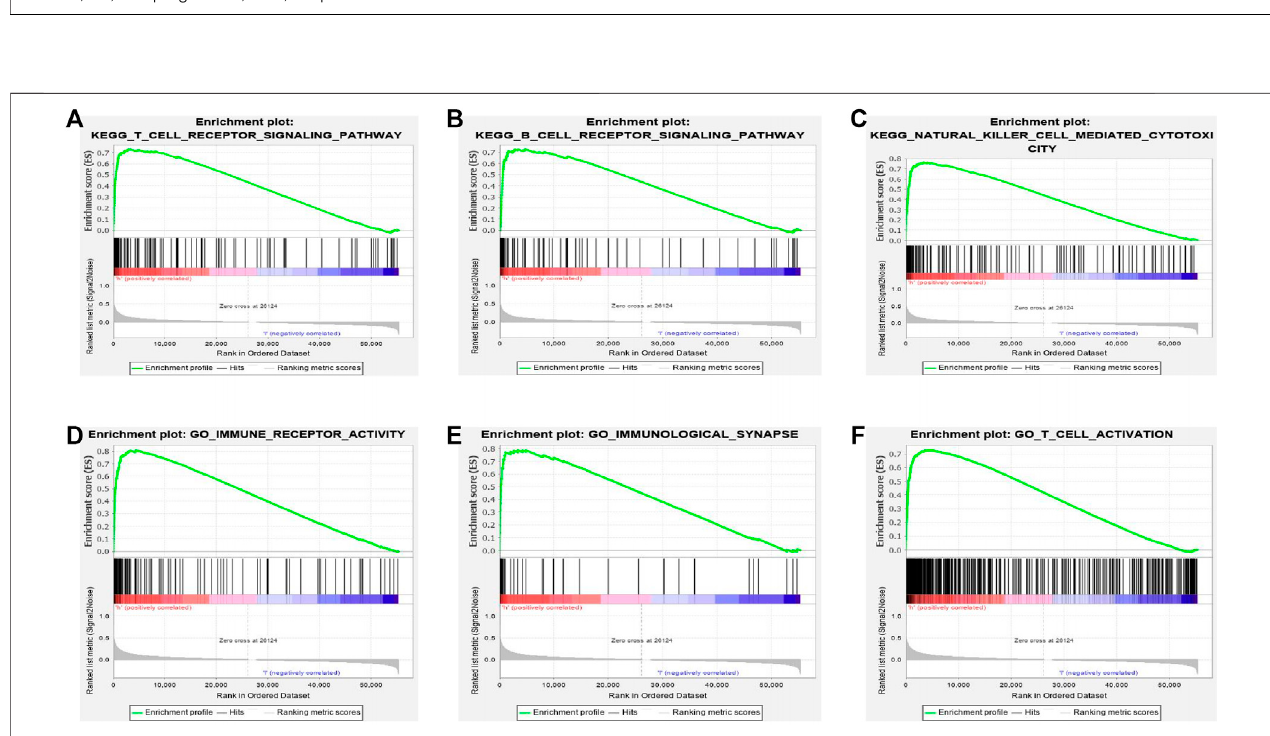
FIGURE 4 | Gene set enrichment analysis (GSEA) indicated the most signi fi cant pathways and genes related with BTN3A2 based on TCGA. GSEA results show gene sets six 6 hallmark gene-sets, (A) “ KEGG_T_CELL_RECEPTOR_SIGNALING_CASCADE, ” (B) “ KEGG_B_CELL_RECEPTOR_SIGNALING_CASCADE, ” (C) “ KEGG_NATURAL_KILLER_CELL_MEDIATED_CYTOTOXICITY, ” (D) “ GO_IMMUNE_RECEPTOR_ACTIVITY, ” (E) “ GO_IMMUNOLOGICAL_SYNAPSE, ” and (F) “ GO_T_CELL_ACTIVATION. ”